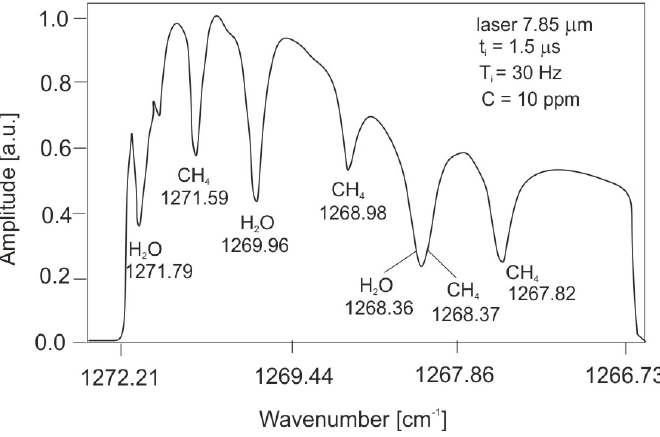
Figure 9. Atmospheric transmission spectrum with